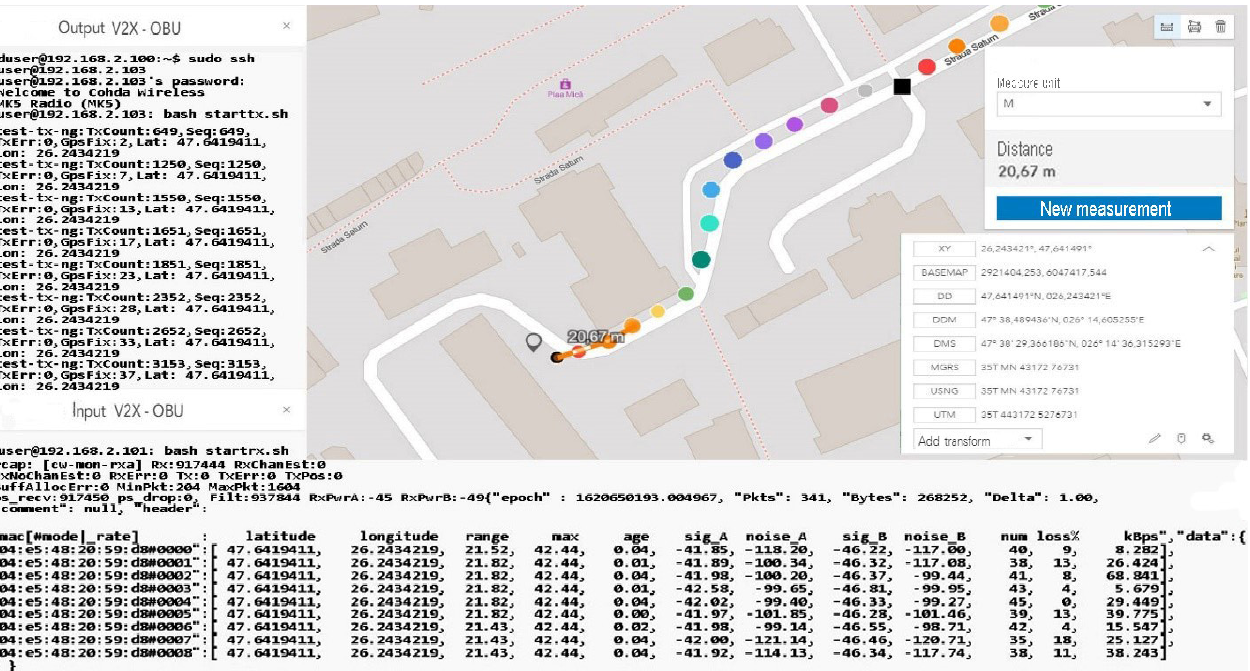
Figure 30. Simulated scenario at a distance of 20 m from the transmitter in a controlled environment.